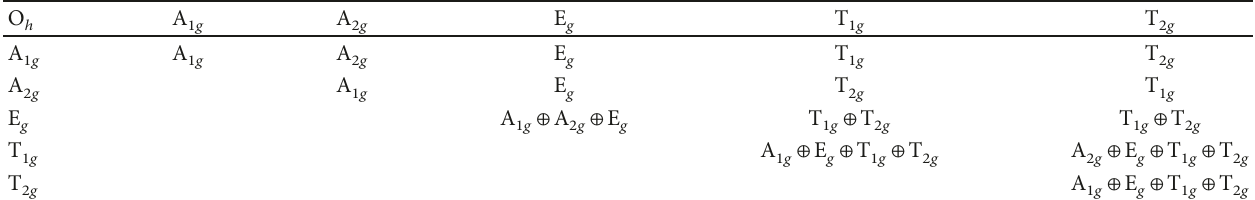
and O crystal fi eld 10D q and the resulting 3d h symmetry. h